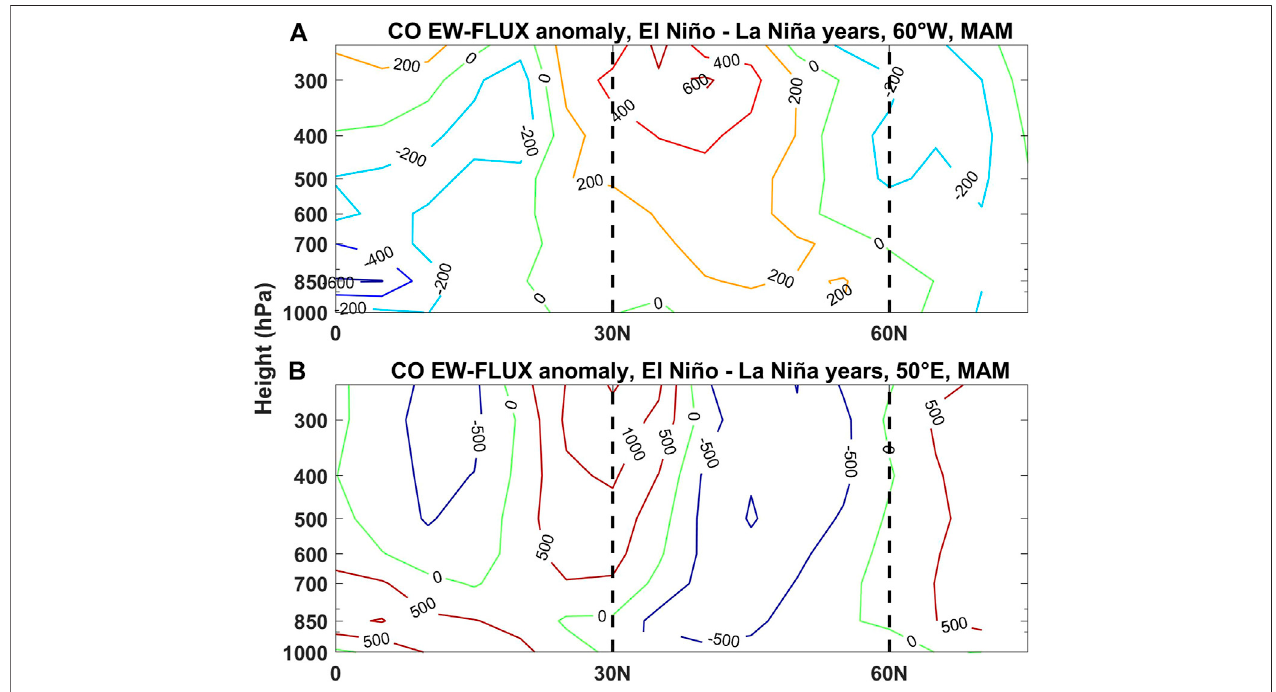
FIGURE10|(A) Thelatitude-altitudecrosssectionofCO fl uxdifference(inppbv m s − 1 )betweenElNiñoandLaNiñayearsinMAMalongthewesternborderofthe NAE (60 ° W). (B) The same as (A) , but along the eastern border of the NAE (50 ° E). The dashed vertical lines at 30 ° N and 60 ° N indicate the latitudinal borders of the NAE. Positive fl ux is from west to east.